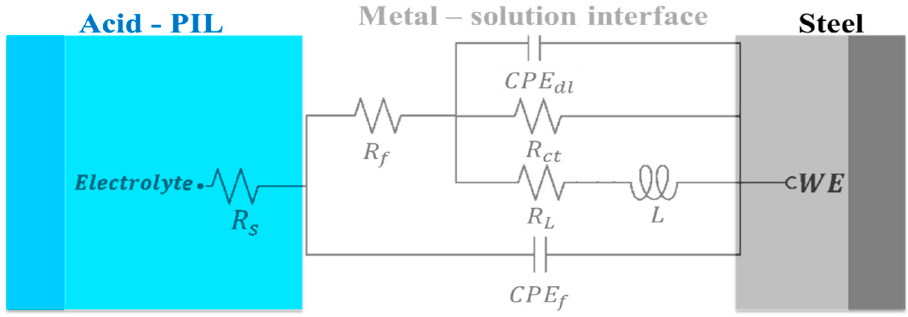
Figure 10. EEC for fitting the EIS experimental data of API 5L X60 steel in the acid—CI medium. The constant phase elements (CPEs) indicate the ideality deviation of the capacitances of the EIS spectra and are represented in the Nyquist plots as depreciated semicircles (Figures 7–9). The CPEs were calculated from two parameters: the proportional factor ( Y 0 ) and the exponent n . The latter is associated with possible surface irregularities due to roughness, inhibitor adsorption or the formation of porous layers. The CPE impedance is defined by Equation (1): where j is an imaginary number ( − 1) 1/2 and ω = 2 π f is the angular frequency of the maximal value of the real impedance; n falls within a close interval ( − 1 ≤ n ≥ 1), where − 1, 0 and 1 are usually related to an inductor, resistor and capacitor, respectively [42,43]. The pseudocapacitance derived from a CPE can be calculated by means of Equation (2): In the interfacial phenomena controlled by diffusion, relaxation processes occur at spe- cific frequencies and temperatures; in an electrochemical system, the characteristic constant of such a process within the time domain is known as the relaxation time ( τ dl ), which is defined as the time necessary for the charge distribution to recover the equilibrium state and is commonly employed to distinguish the polarization effects that normally overlap in the frequency domain and that can be attributed to underlying physical processes [44,45]. The relaxation time ( τ dl ) is given by Equation (3) [46,47]: